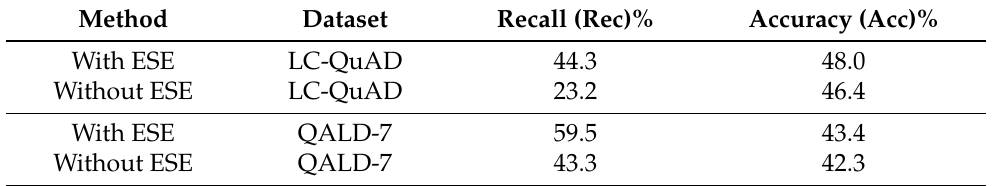
Table 4. Experimental comparison results of With RSE and Without RSE